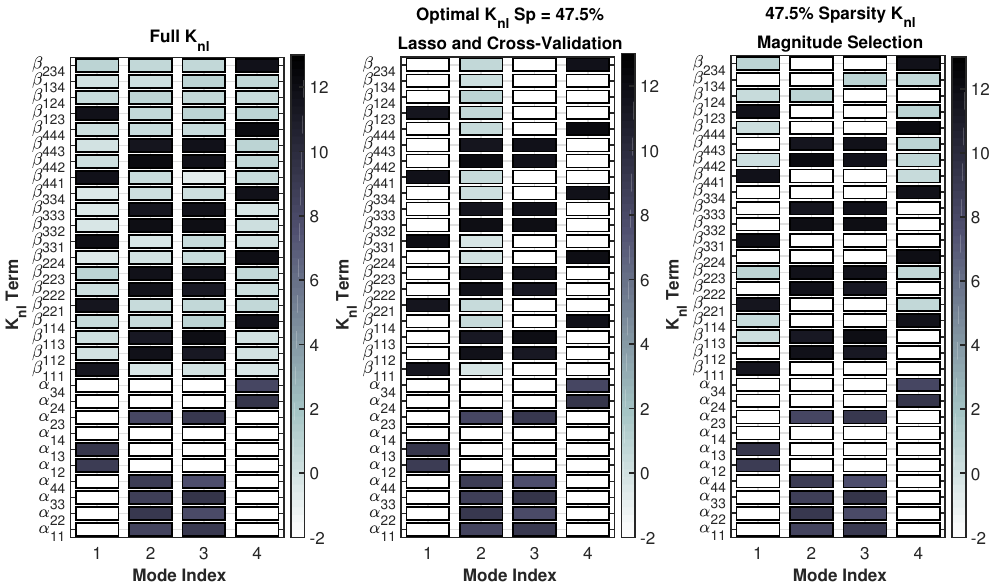
Figure 9. Nonlinear stiffness coefficient matrices for three different sets of sparsity approaches: (1) The least squares solution (all terms shown would be retained), (2) the optimal solution identified via cross-validation (terms in white are eliminated), and (3) a solution in which terms with the smallest magnitude are removed (terms in white are eliminated). The colorbar gives the log of the stiffness term; values below 10 − 2 are